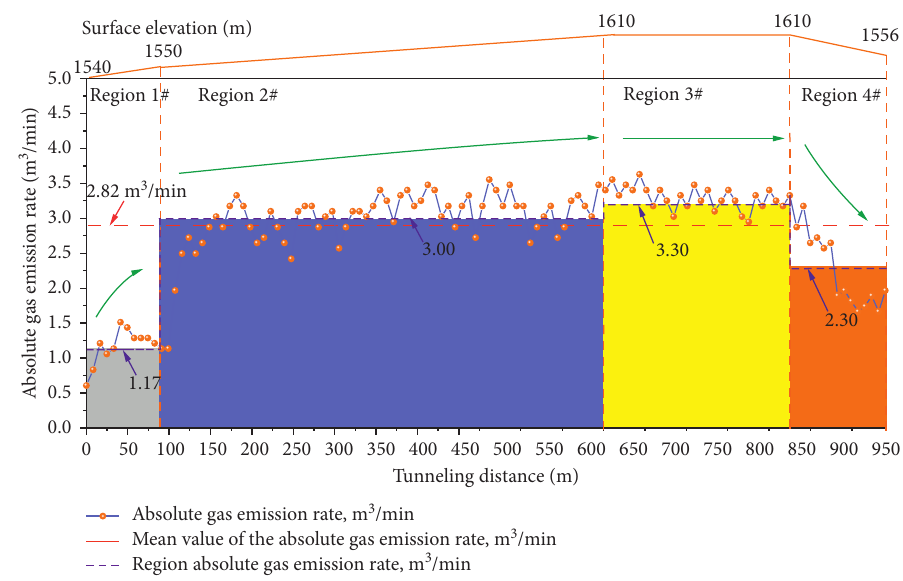
Figure 8: Curve of the absolute gas emission rate of the ventilation roadway in the 10502 working face during